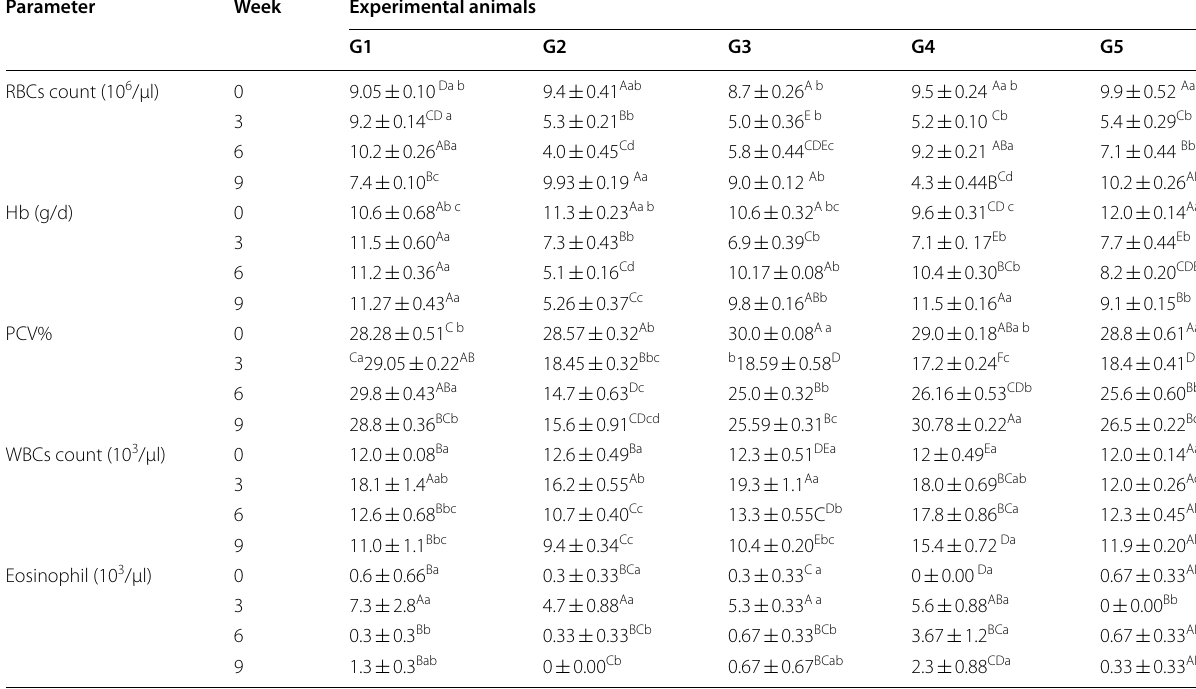
G, lambs group Capital letters: means within the same column of different letters are significantly different at ( P < 0.01). Small letters: means within the same row of different letters are significantly different at ( P <